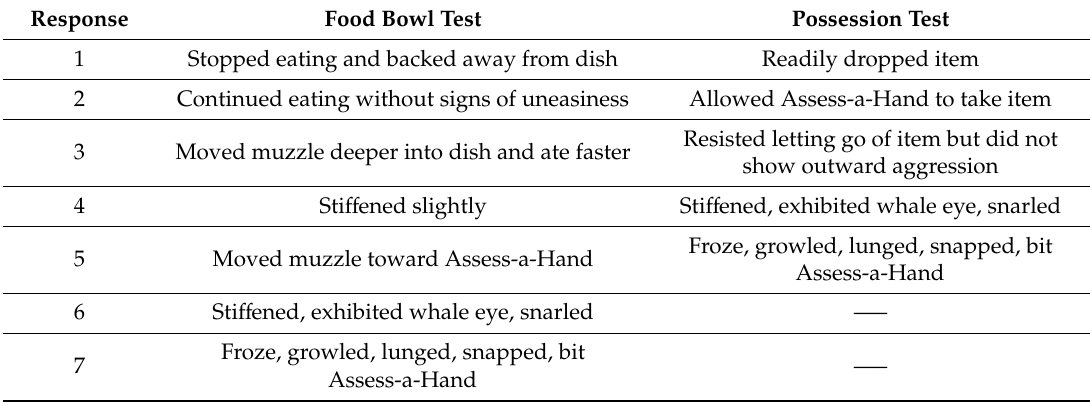
Table 1. Possible responses during food bowl and possession tests on the canine behavioral evaluation at the shelter 1